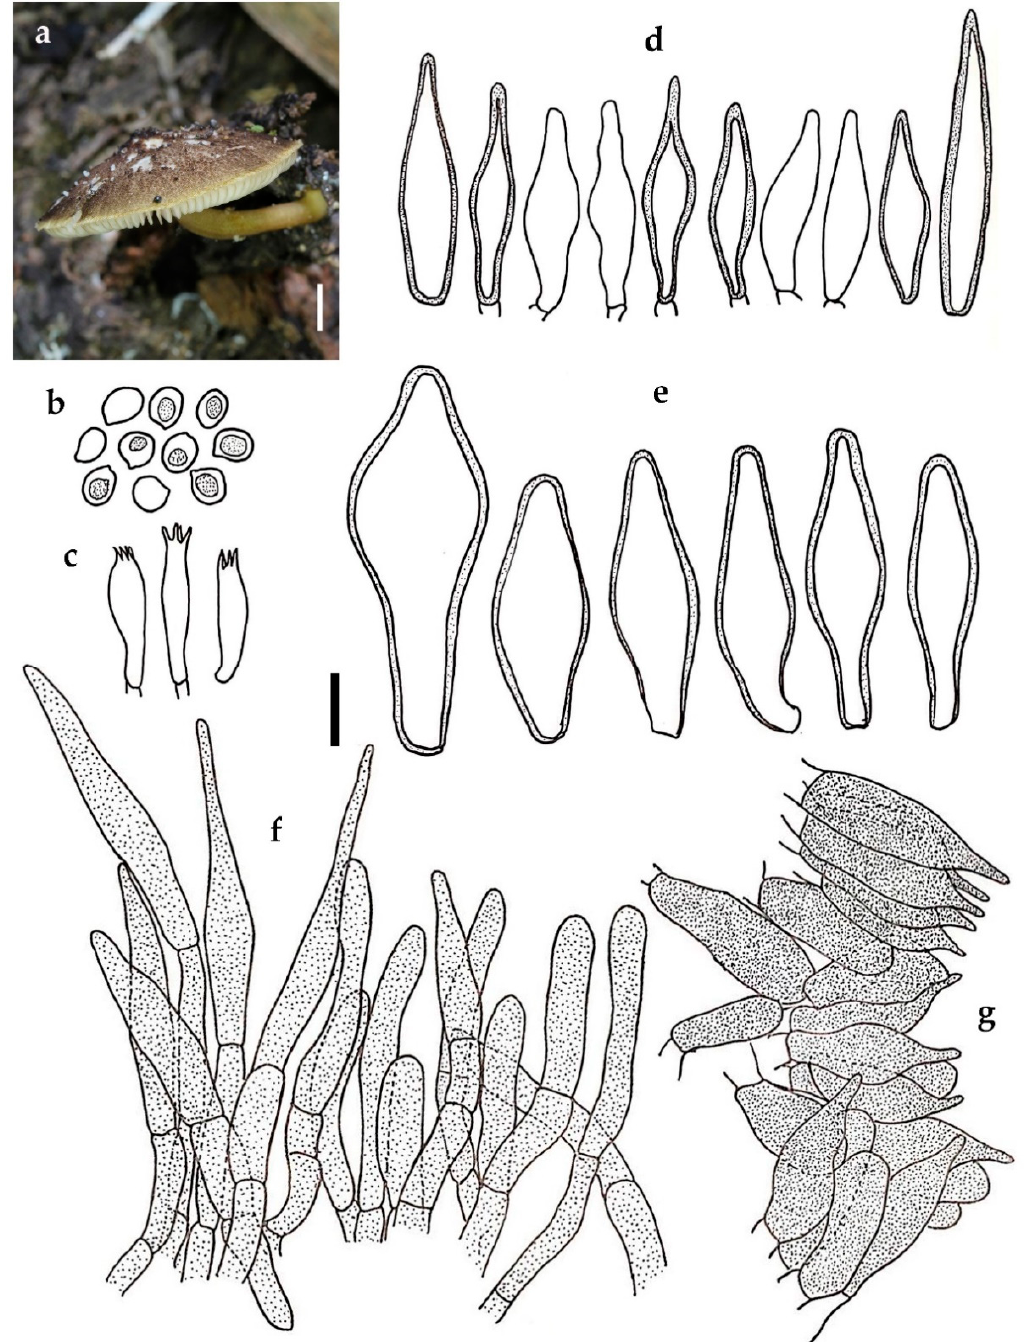
Figure 5. Pluteus saisamorniae BKF 10213 (holotype): ( a ) habit; ( b ) basidiospores; ( c ) basidia; ( d ) cheil- ocystidia; ( e ) pleurocystidia; ( f ) pileipellis element; ( g ) caulocystidia. Scale bars: ( a ) = 5 mm; ( b – g ) = 10 μ